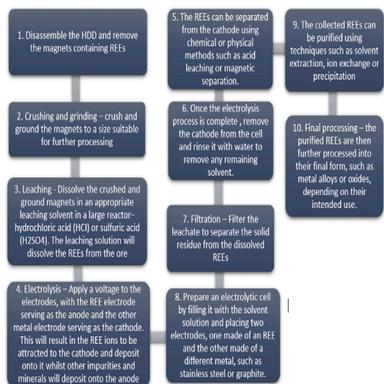
Flow chart for the steps in extraction of Rare earth elements identified from the e waste starting from disassembling, separation, extraction and processing.